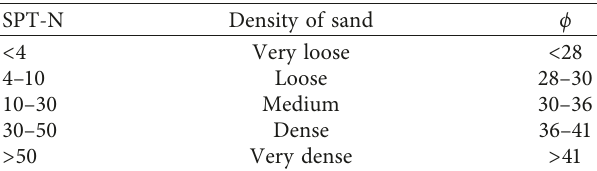
Table 2: N value at each range of the repose angle of soil.